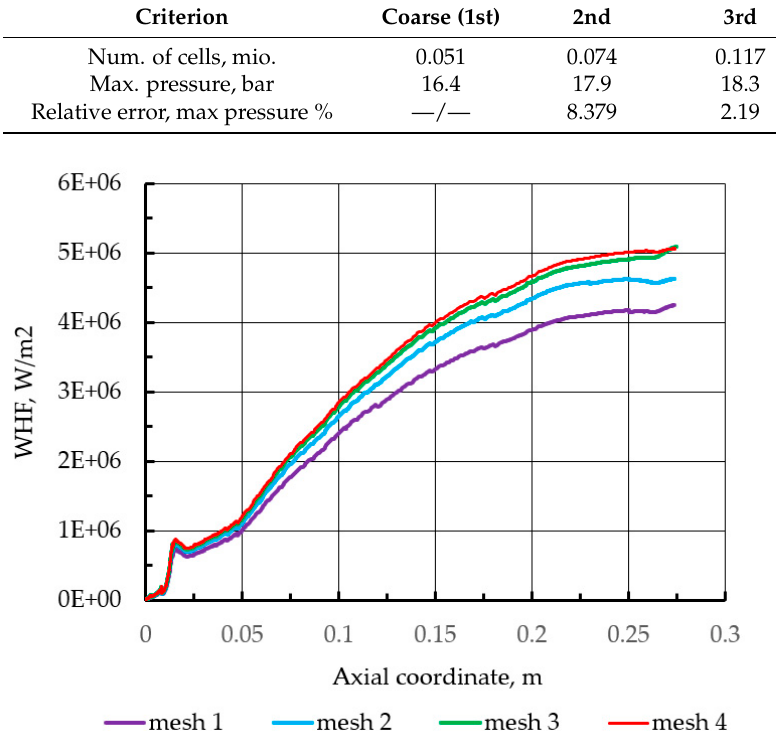
Figure 3. Mesh independence study for wall heat flux.